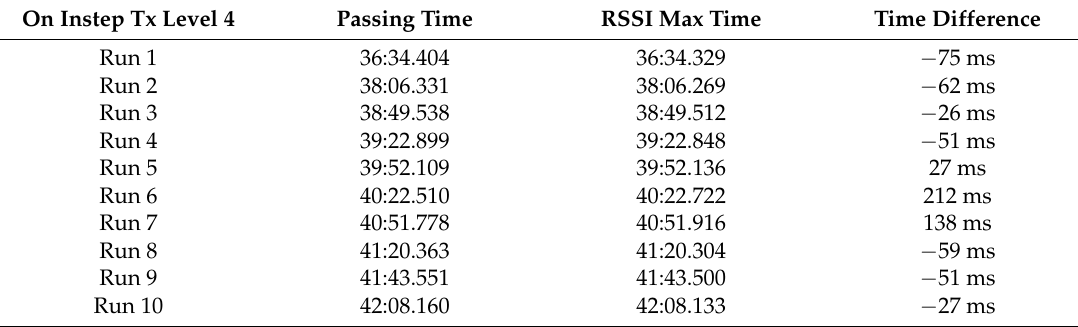
Table 8. The dynamic experiment when the Tx power of the BLE Tag on the instep is set at Level 4. On Instep